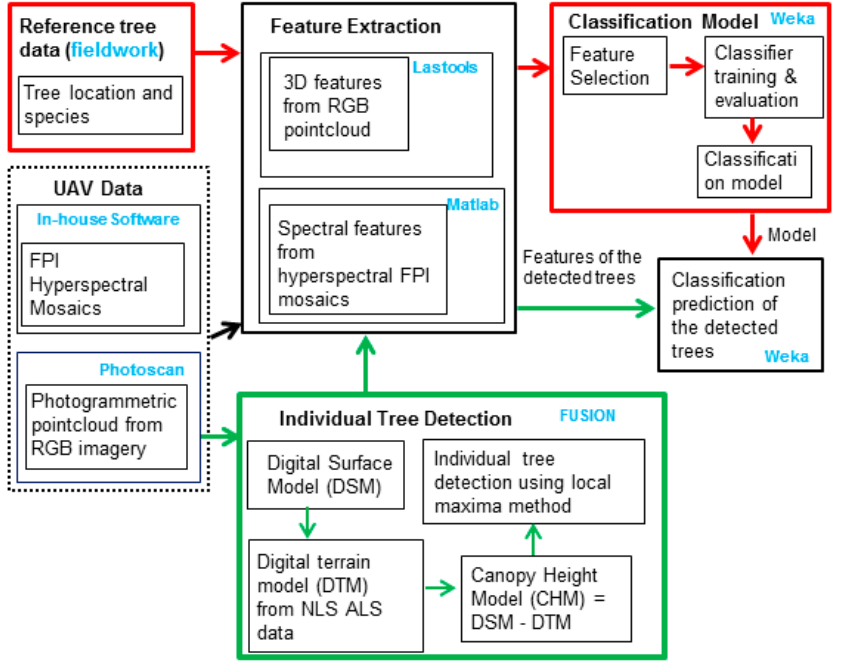
Figure 4. Workflow for individual tree detection and classification procedure.